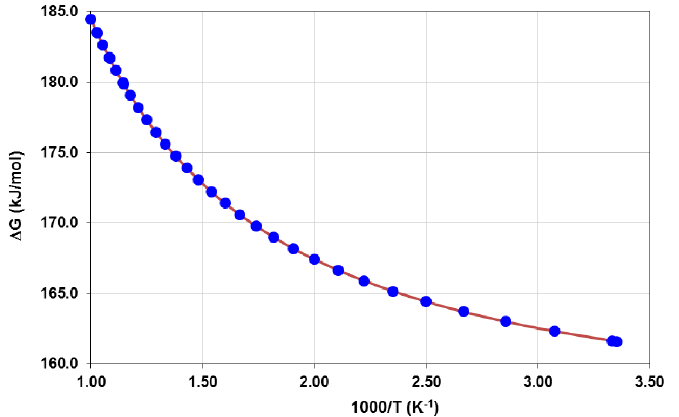
Figure 9. Calculated Gibbs Free energy barriers at different temperatures corresponding to the forward reaction given by Equation (3) at the PWC/DNP theory level for the YSZ/Au model